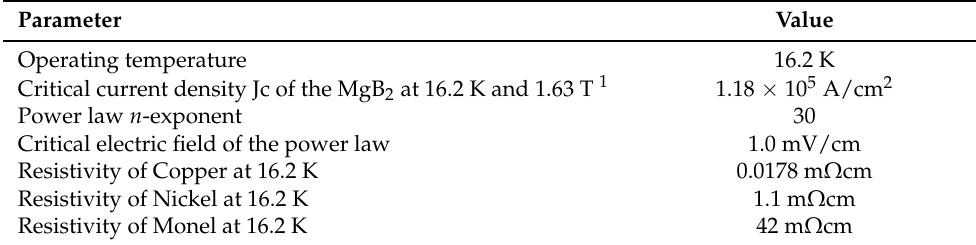
Table 3. Parameters used for the numerical calculation.